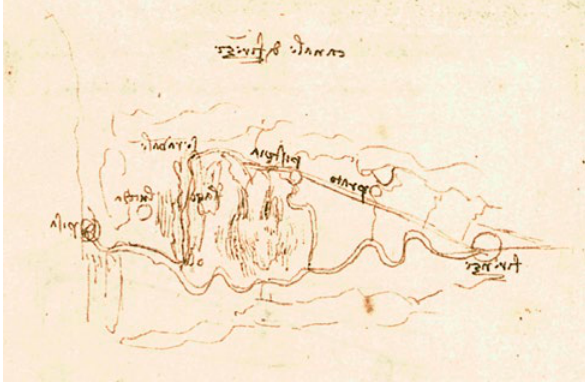
Figure 2. C.A., fol. 127r: detail of the topographic map with the plain of Florence and the lower Valdarno.